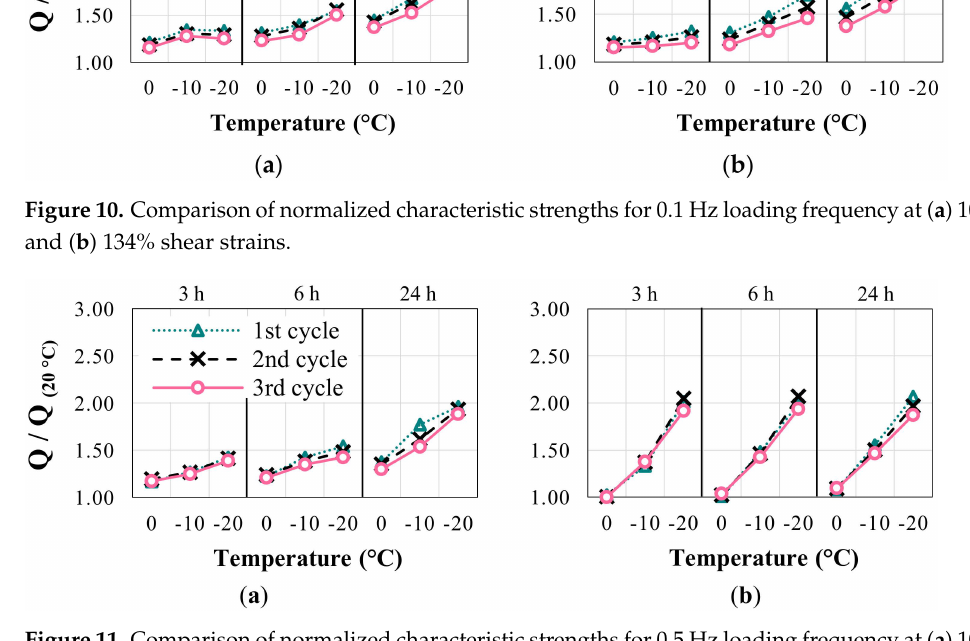
Figure 11. Comparison of normalized characteristic strengths for 0.5 Hz loading frequency at ( a ) 100% and ( b ) 134% shear